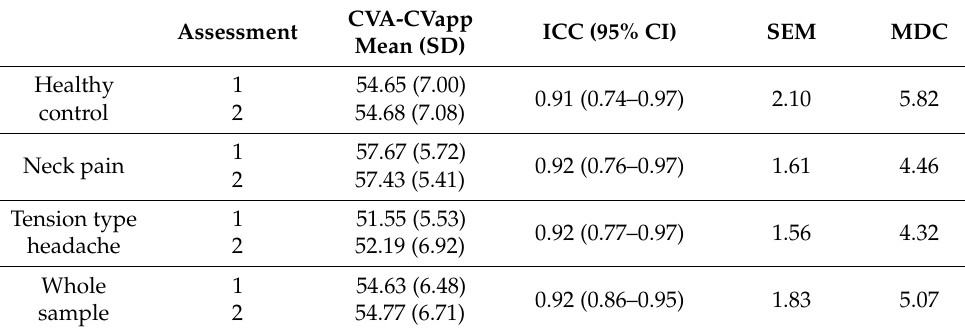
Table 2. Test-retest reliability for subgroups and the whole sample for the